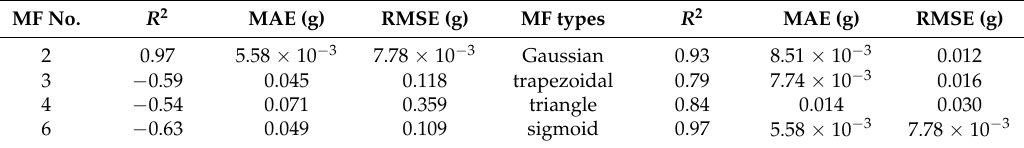
Table 3. Membership function (MF) numbers and type’s performance